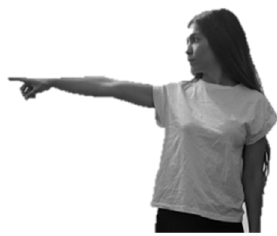
Figure 1. Our attention is reflexively shifted toward where this person is looking and pointing.